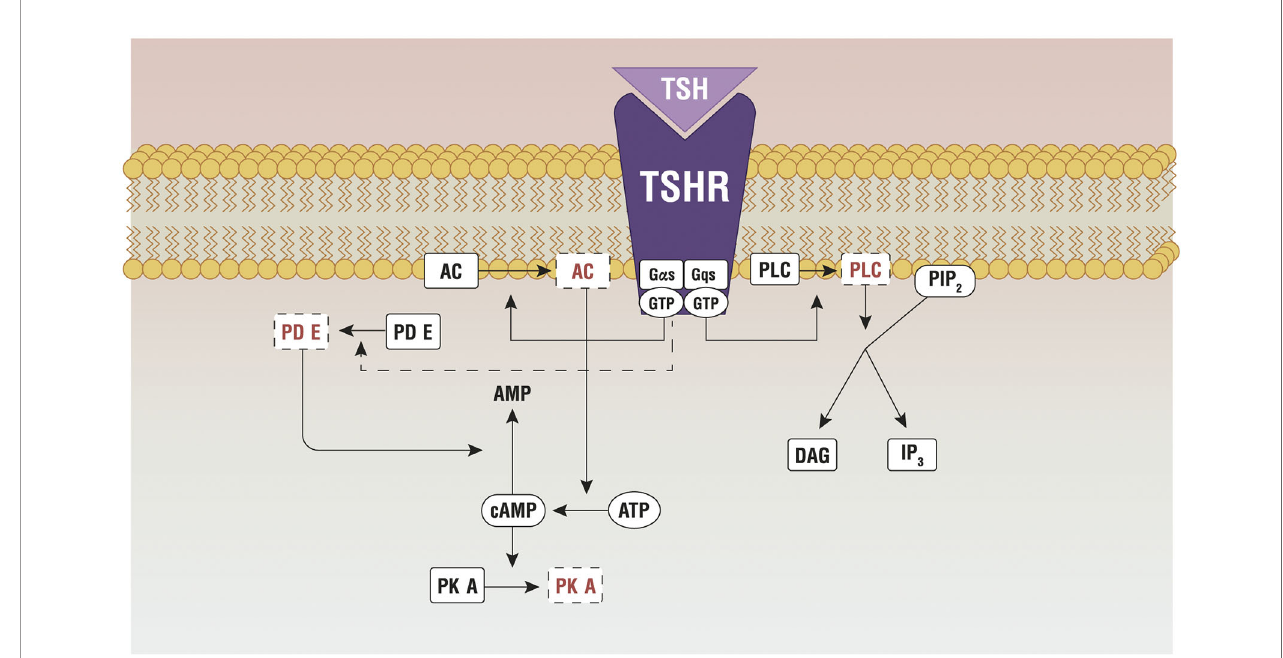
FIGURE 2 | Principal pathways active by the TSH-TSHR binding. AC, adenylate cyclase; AKT, protein kinase B; ATP, adenosine triphosphate; cAMP, cyclic adenosine monophosphate; G a s/Gqs, G protein; GTP, guanosine triphosphate; IP3, inositol triphosphate; mTOR, protein kinase (mammalian target of rapamicin); PDE, phosphoesterase; PIP2, phosphatidylinositol 4,5- biphosphate; PKA, protein kinase A; PLC, phospholipase C; TSHR, TSH Receptor; TSH, thyroid stimulating hormone. Reproduced with the permission from Benvenga et al. (23) (License No